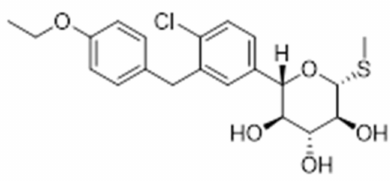
Figure 9. Structure of Sotaglifozin, a Dual SGLT1 / SGLT2